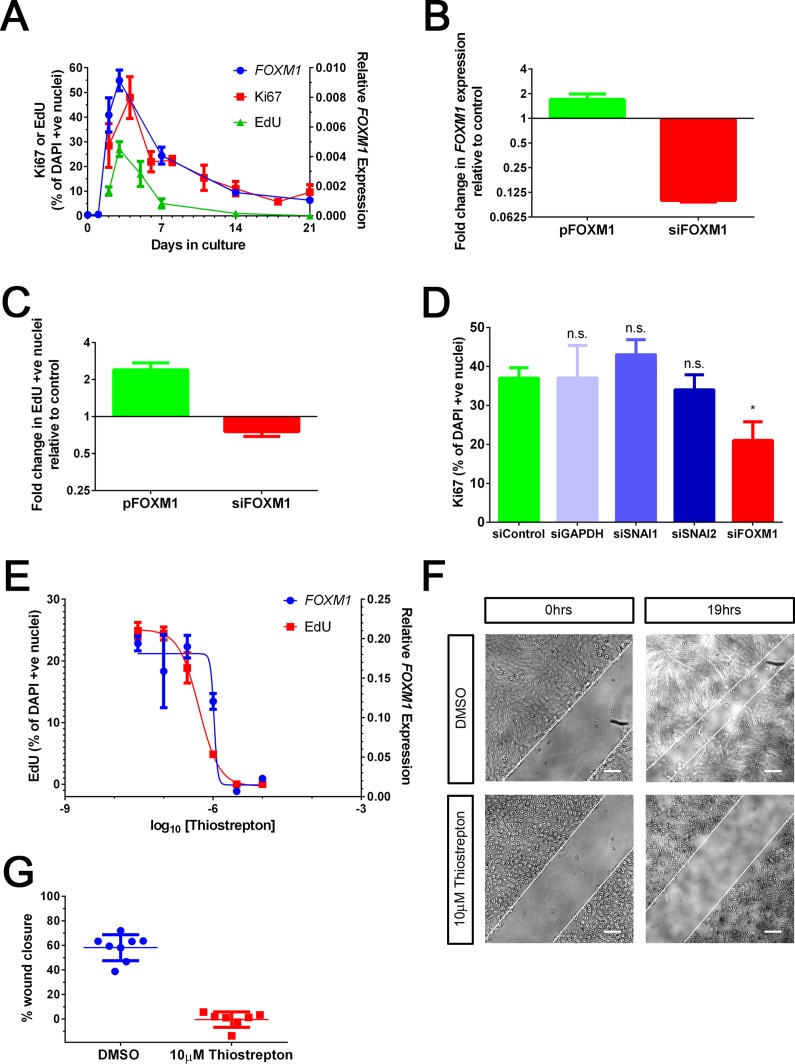
FOXM1 regulates RPE proliferation.A. Graph showing quantification of immunocytochemistry where % Ki67 (n = 3) or % EdU (n = 6) is plotted on the left Y axis and relative expression of FOXM1 transcript (n = 3; ACTB used as housekeeping gene) on the right Y axis over days in culture (x axis). B. Quantification of change in FOXM1 transcript upon transient overexpression (pFOXM1) or knockdown (siFOXM1), 48h post transfection, measured by qPCR. Data is normalized to appropriate controls (Empty vector for pFOXM1 and non-targeting siRNA for siFOXM1). Bars represent Mean + SD (n = 3). C. Quantification of change in EdU incorporation upon FOXM1 overexpression or knockdown, 72h post transfection. Data is normalized to appropriate controls (Empty vector for pFOXM1 and non-targeting siRNA for siFOXM1). Bars represent Mean + SD (n = 4). P<0.0001 (Student’s t-test). D. Quantification of immunocytochemistry for Ki67 upon siRNA mediated knockdown of non-targeting control, GAPDH, SNAI1, SNAI2 and FOXM1, at Day 6 post transfection. Bars represent Mean + SD (n = 3). n.s non-significant, * p<0.05 Student’s t-test. E. Effect of Thiostrepton on EdU incorporation [left Y axis, red] and FOXM1 transcript expression measured by qPCR [right Y axis, blue]. Bars represent Mean ± SD (n = 6). F. Bright-field microscopy showing a scratch introduced in a RPE monolayer at 0 hrs and 19hrs in the presence of DMSO or 10μM Thiostrepton. Edge of the scratch is marked with a white line. Scale bar = 200 μm. G. Quantification of F (above). Bars represent Mean + SD (n = 7). P<0.0001 (Student’s t-test)